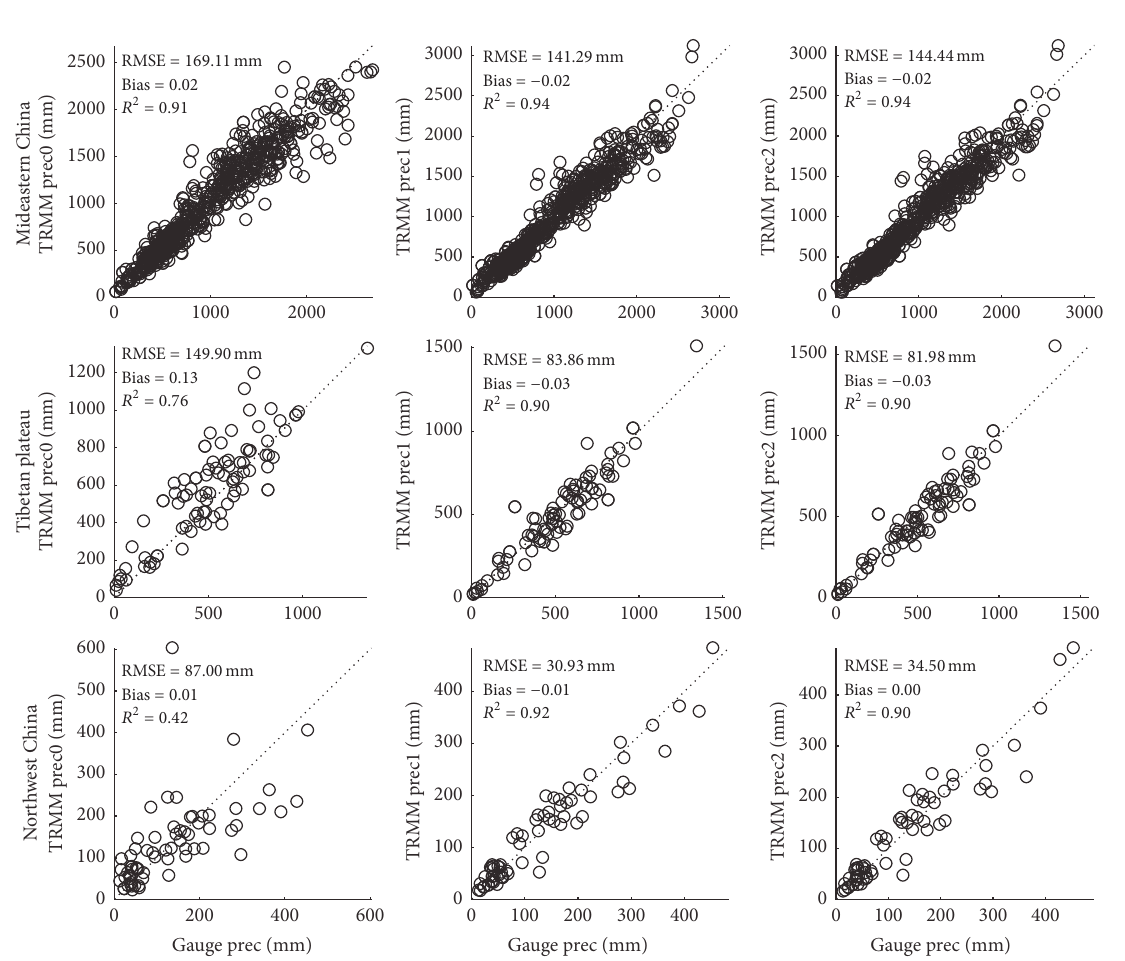
Figure 6: Scatterplots of annual gauge precipitation versus original/corrected TRMM precipitation in the three regions at station scale. Table 1: Validation of annual TRMM precipitation in the three regions in 2014 at grid scale.